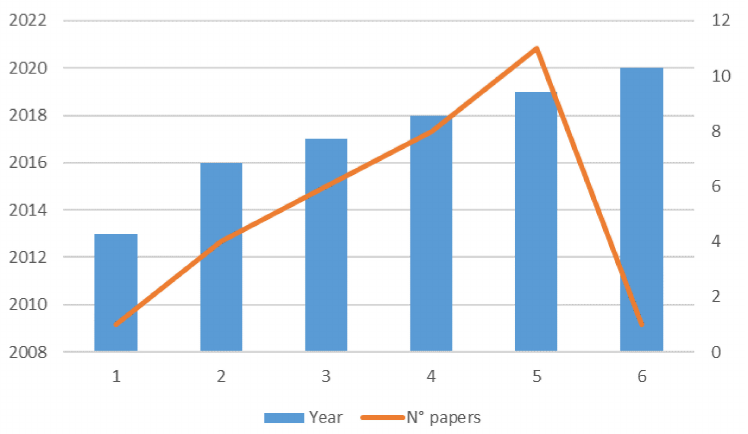
Figure 6. Distribution by year (source: